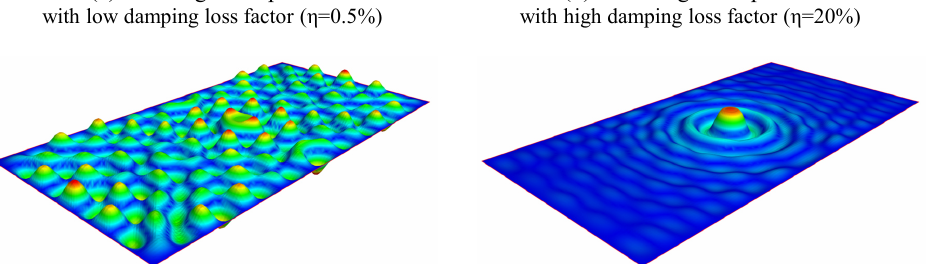
Figure 6. Comparison of ( a ) a high-pressure laminate (HPL) panel with a very low damping loss factor of η = 0.5%, which represents the standing wave pattern; and ( b ) a HPL panel with a high damping loss factor of η = 20%, which represents the traveling wave pattern.